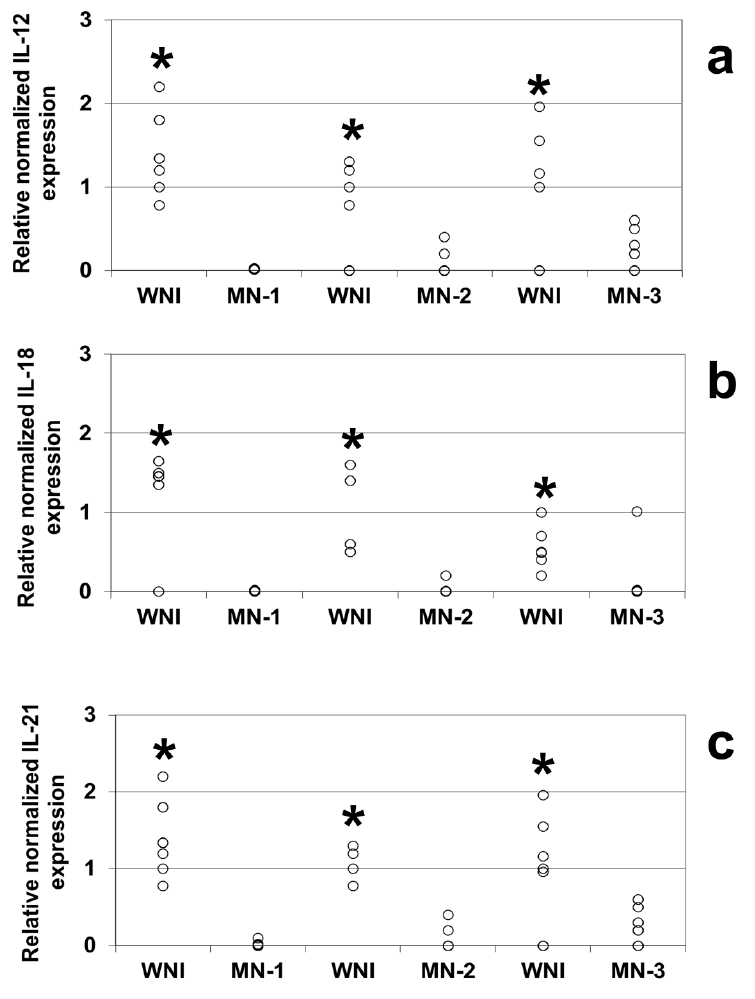
Figure 1. Gene expression levels from well-nourished and malnourished children, IL-12 ( a ), IL-18 ( b ), and IL-21 ( c ) levels were obtained by Real Time PCR. Mononuclear cells were obtained from peripheral blood samples of WNI, MN-1, MN-2 and MN-3. Determinations were made in triplicate, and the points in the graph represent their average. Significant difference: In all cases * WNI vs. MN-1, MN-2 and MN-3, p < 0.05. IL-12: BNI vs. DN1 n = 6; BNI vs. DN2 n = 5; BNI vs. DN3 n = 6. IL-18: BNI vs. DN1 n = 6; BNI vs. DN2 n = 4; BNI vs. DN3 n = 7. IL-21: BNI vs. DN1 n = 7: BNI vs. DN2 n = 4; BNI vs. DN3 n =